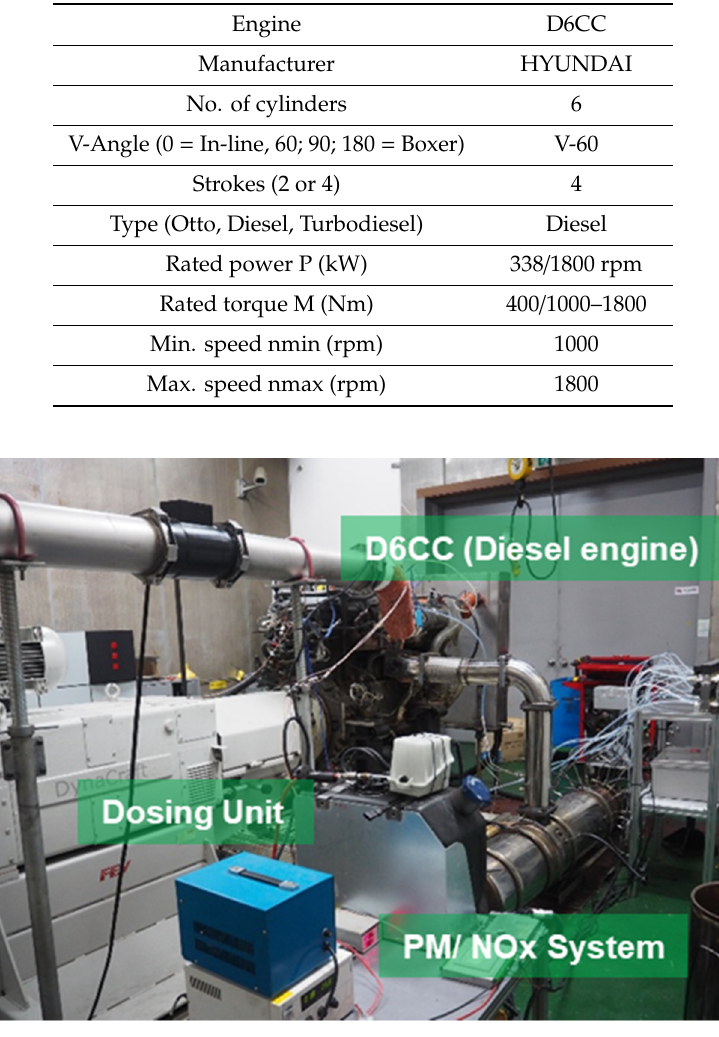
Figure 16. Measurement setup and schematic diagram of the test engine. The mixing process between NO x and ammonia particles occurred from the injector to the catalytic converter. That process was assisted by the mixer fan in the system. The gas analyzer (Horiba MEXA-7100 DEGR) was connected on the outlet of the commercial SCR system from the engine. This process could easily analyze the NO x reduction quality in the system. 5. Conclusions An investigation with two types of urea injectors in an SCR system for heavy-duty diesel engines was conducted. The experiment and simulations were performed to improve ammonia quality from the urea injector. The quality of urea injector performance will assist urea decomposition in the SCR system. The experiment and simulation were based on a 12,000 cc heavy-duty diesel engine operating at 1000 rpm. This engine can produce 513 kg/h of mass flow and a 371 °C exhaust temperature. The parameters used in this study can be a benchmark to obtain similar results at different engine capacities and engine speed conditions.